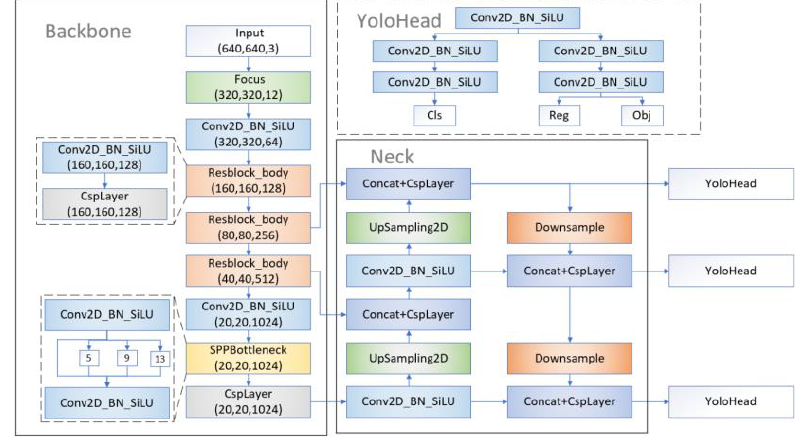
Figure 1. Model structure of YOLOX.